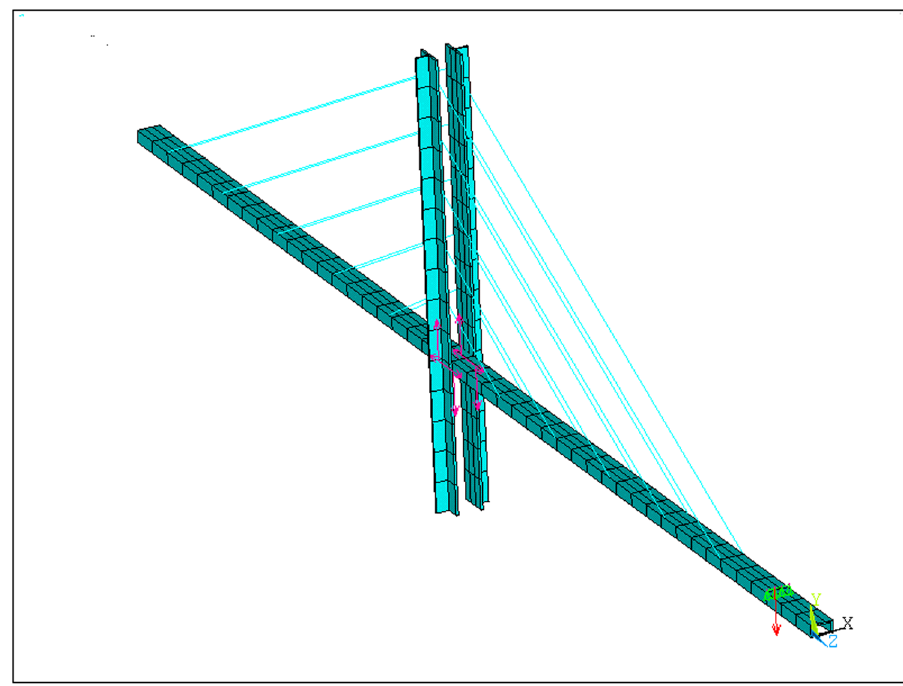
Figure 4: FE model by ANSYS program. divided into 45 elements. Also, each cable was consid - ered as one element, as the total cable became 20 ele - ments; 185 solid elements are used to model the pylon and girder in three dimensions. They are made up of eight